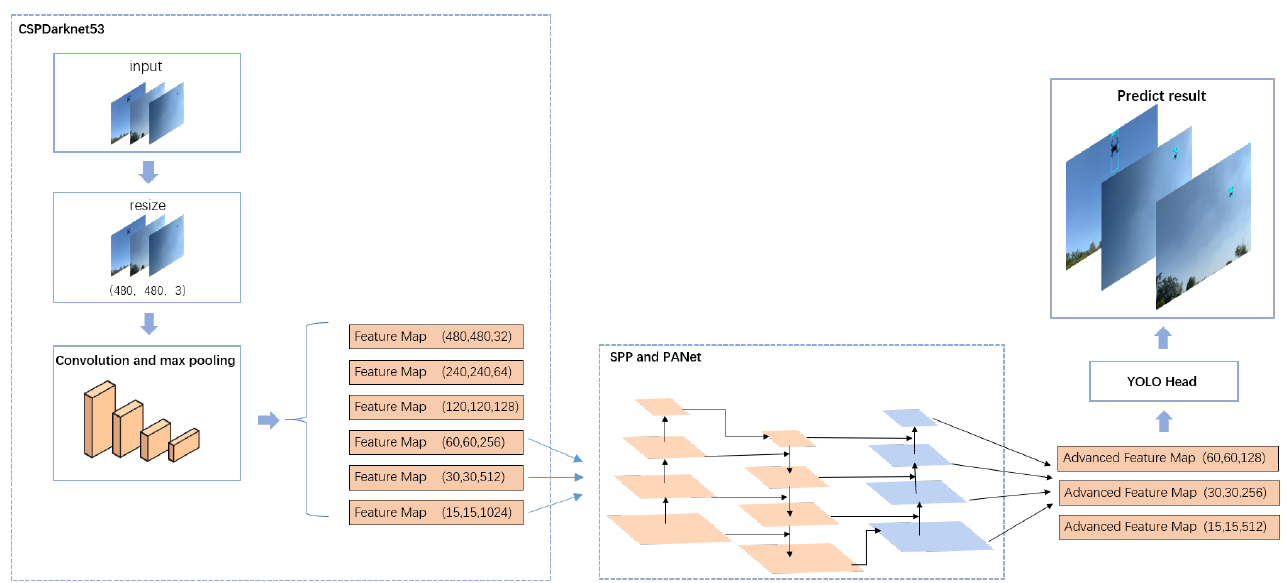
Figure 3. Structure and process of